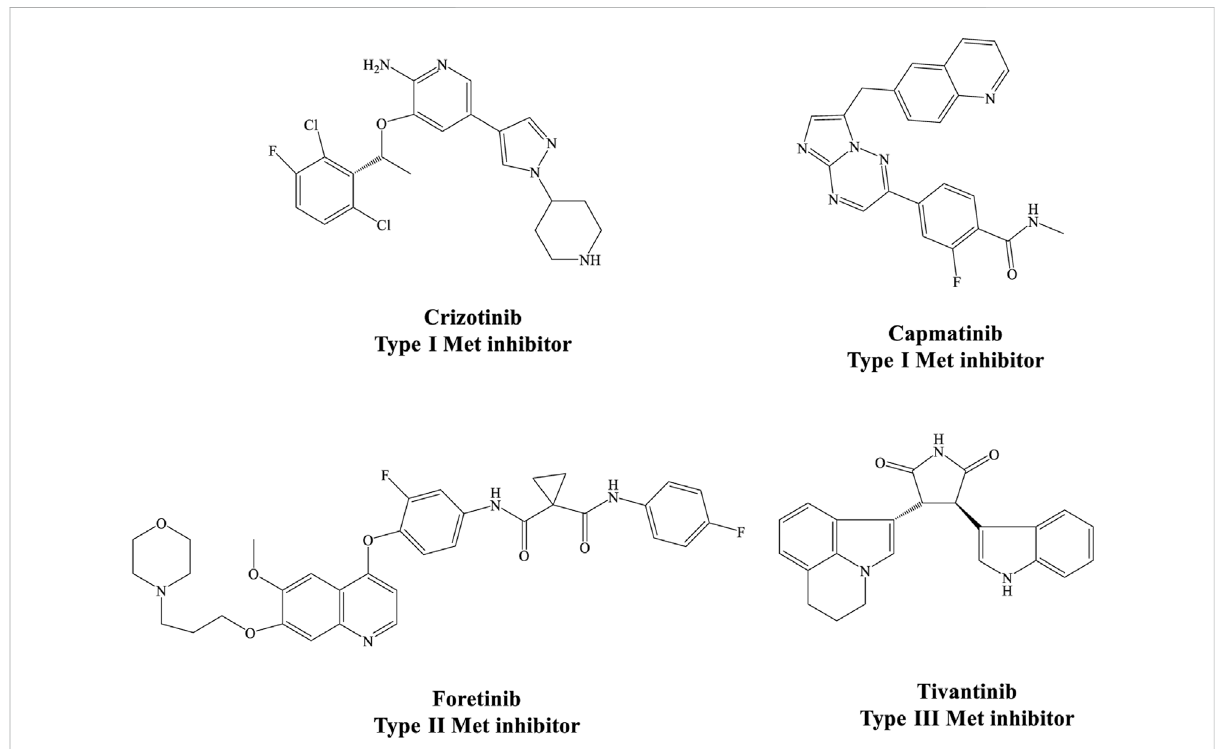
FIGURE 1 Different structural types of small-molecule MET kinase